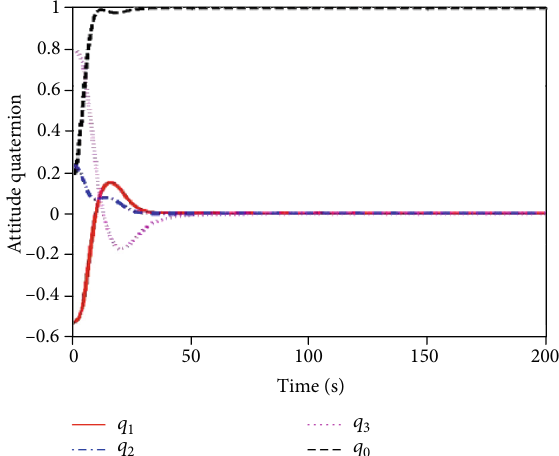
Figure 14: Time histories of control input in Case